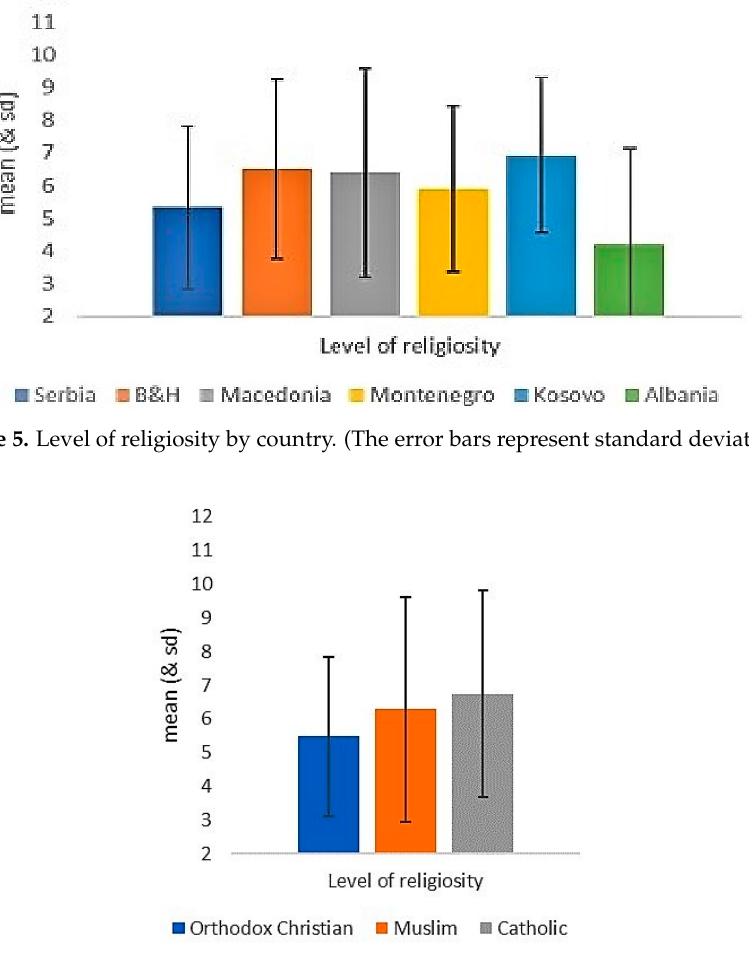
Figure 6. Level of religiosity by confession. (The error bars represent standard deviation).